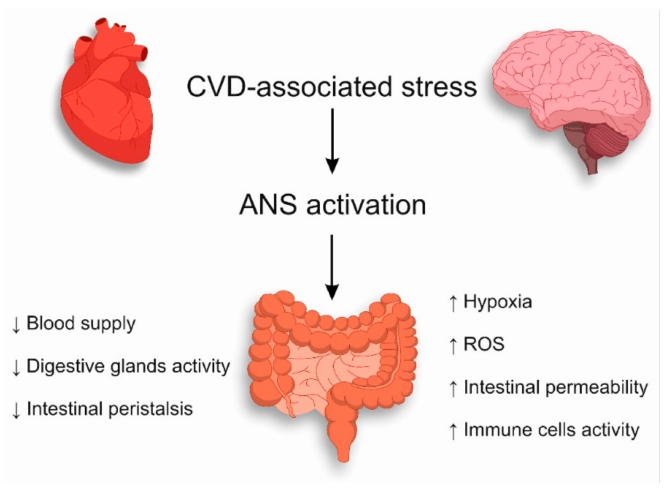
Figure 1. Mechanisms of intestinal epithelium damage during CVD-associated